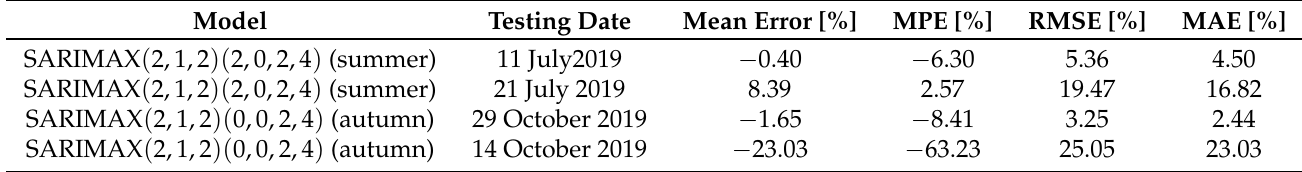
Table 7. A detailed analysis of the SARIMAX model for the best and worst days in summer. SARIMAX model is evaluated because it is shown in Table 6 that it has the best performance based on the Mean Absolute of the Errors (MAE)